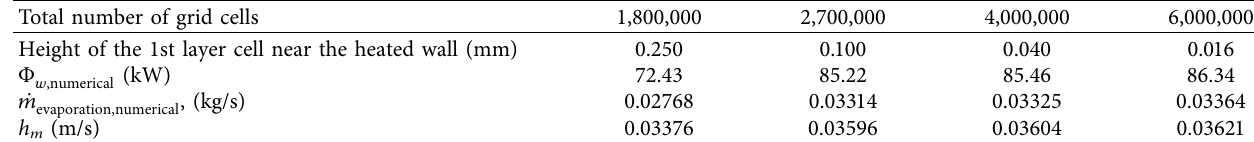
Table 2: Grid independence analysis for the VOF_ UDF method.